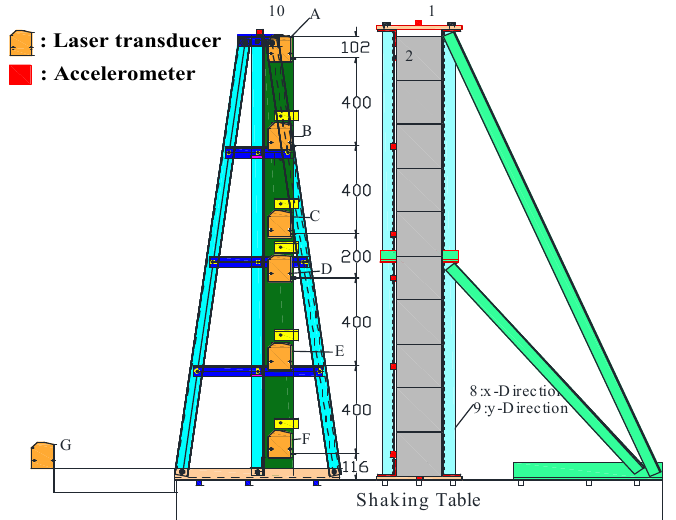
Figure 7. Shaking table test setup: ( a ) side view; ( b ) elevation view.